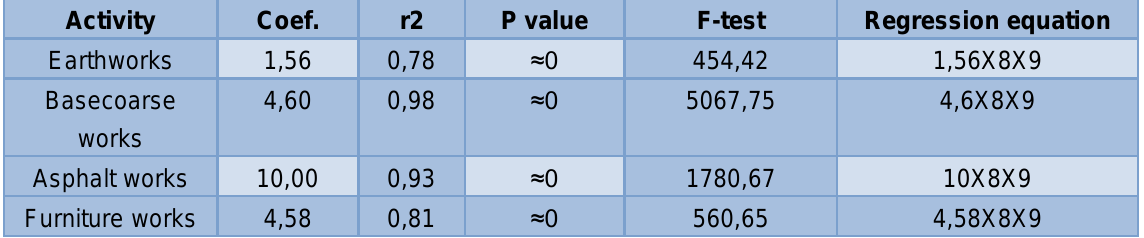
Table 18 Cost of major road construction activities ($) as a function of project size (m2) Then the total project cost can be calculated by summing up the cost of construction activities (model 10). The coefficient of determination r2 for the developed model is